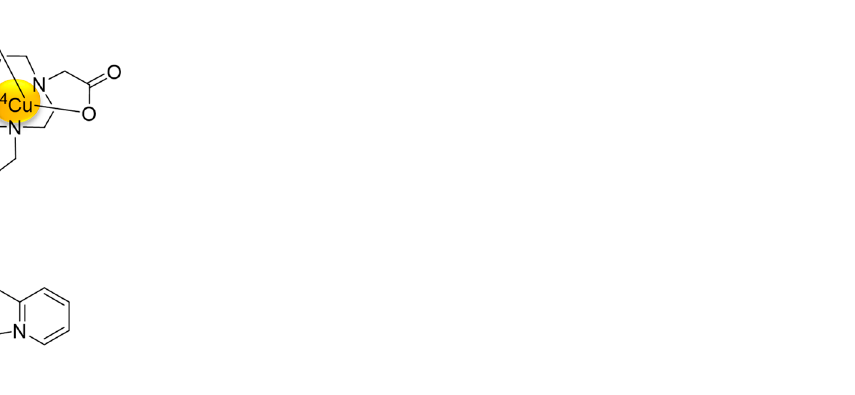
Figure 1. The chemical structure of [ 64 Cu]Cu-NOTA-terpyridine platinum conjugate, [ 64 Cu]Cu- NOTA-C3-TP.